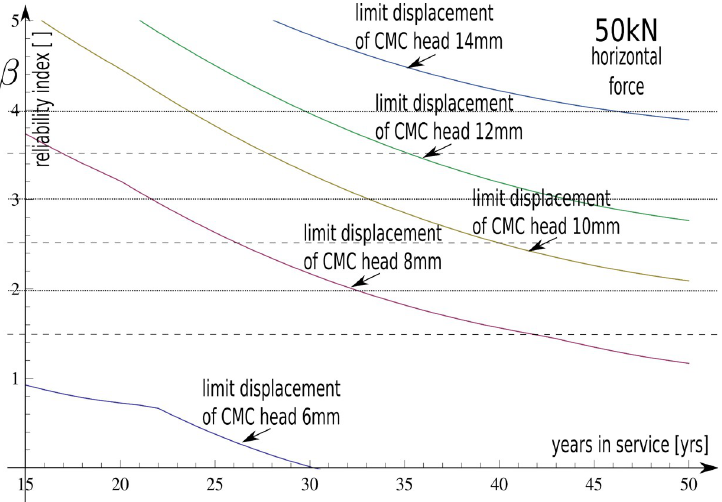
Fig 11. The function of change of reliability index β over time for different values of column head displacement limits hdult = {6, 8, 10, 12, 14}